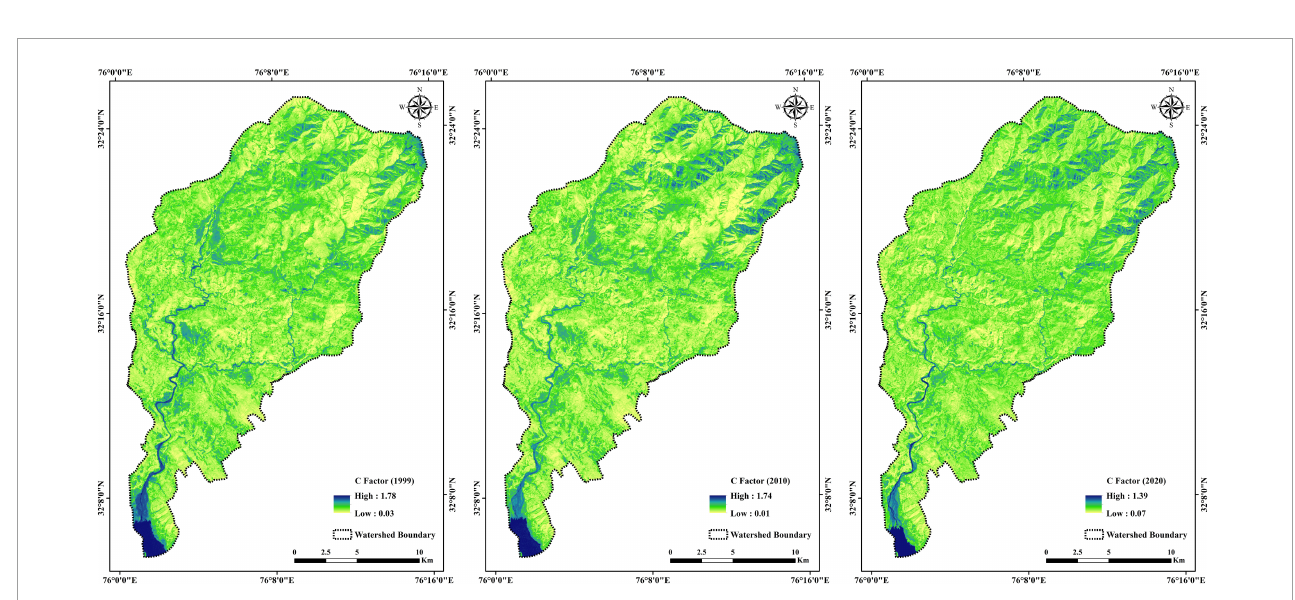
FIGURE12 Maps showing C factor of the Dehar watershed for the years 1999, 2010, and